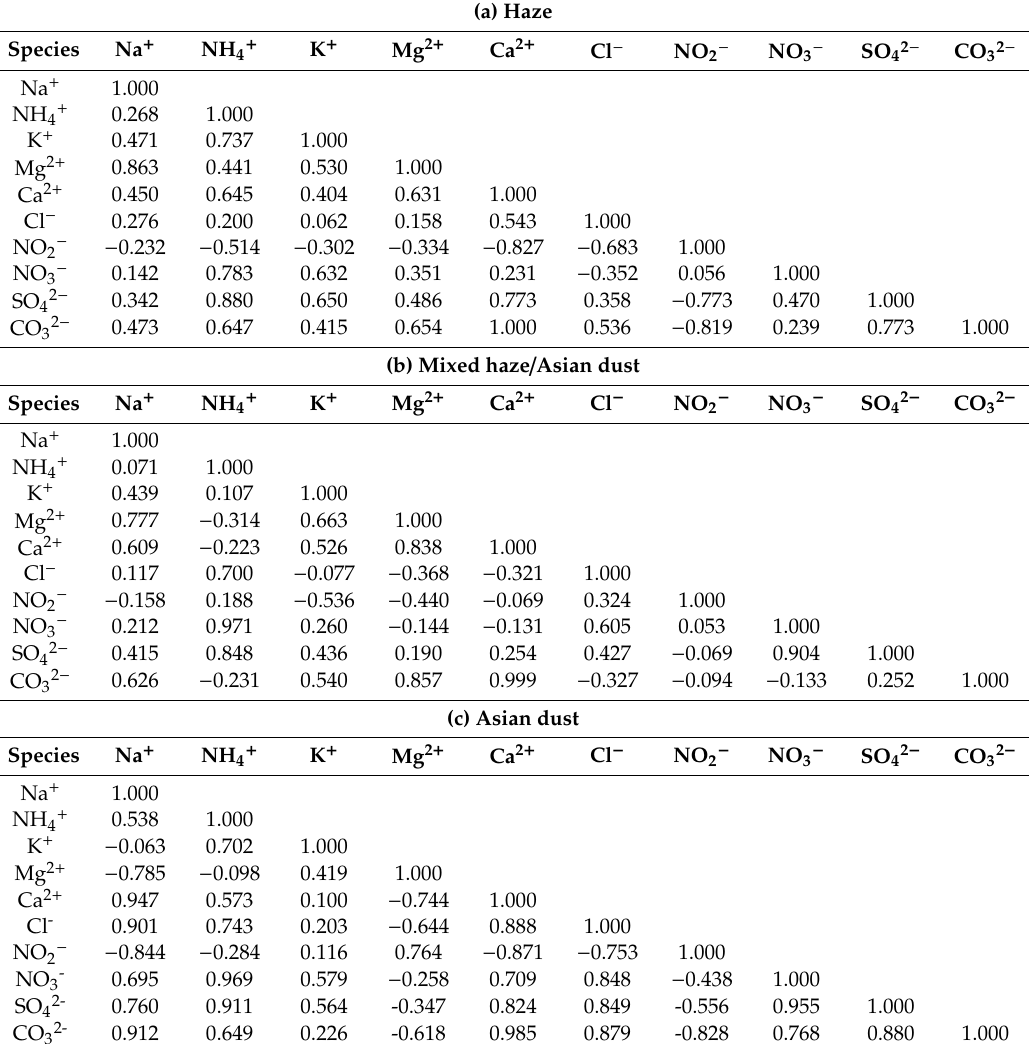
Table 1. Correlation between the ionic species during the ( a ) haze, ( b ) mixed haze / Asian dust, and ( c ) Asian dust